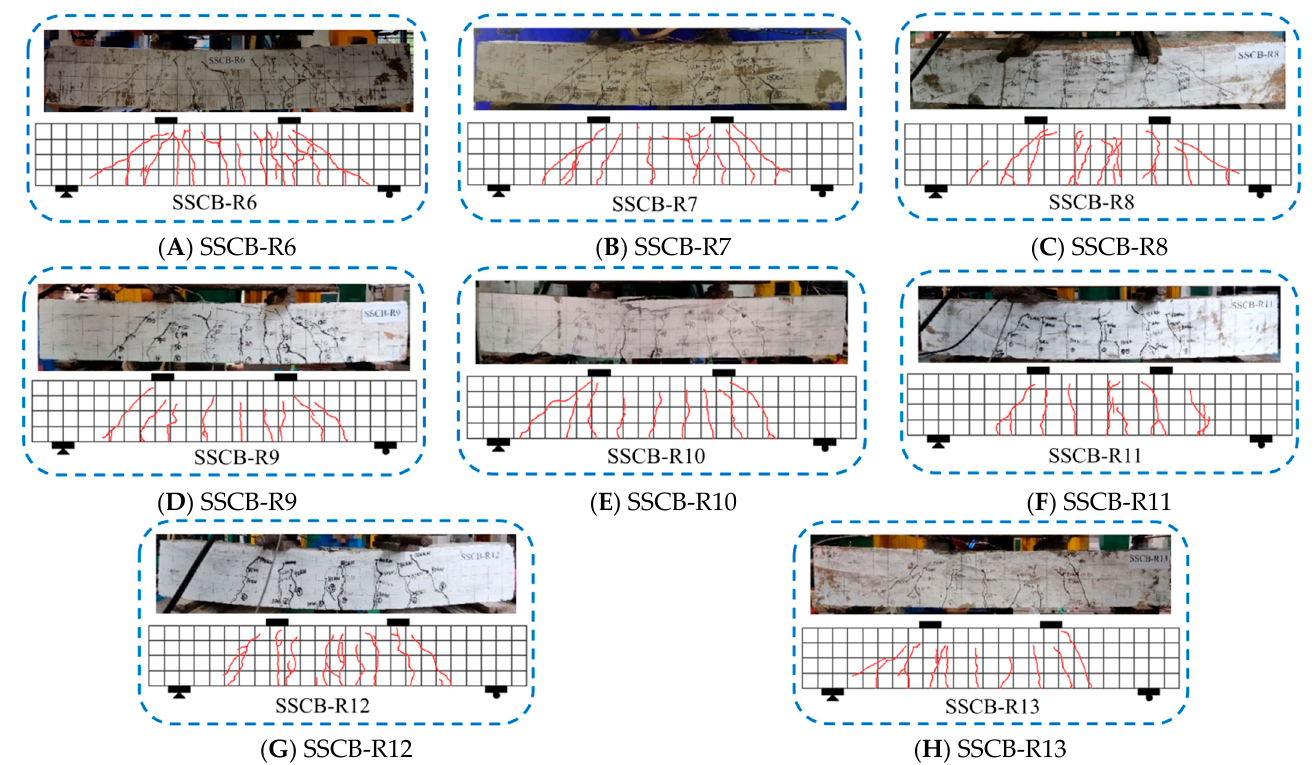
Figure 4. Final failure pattern and fracture distribution.